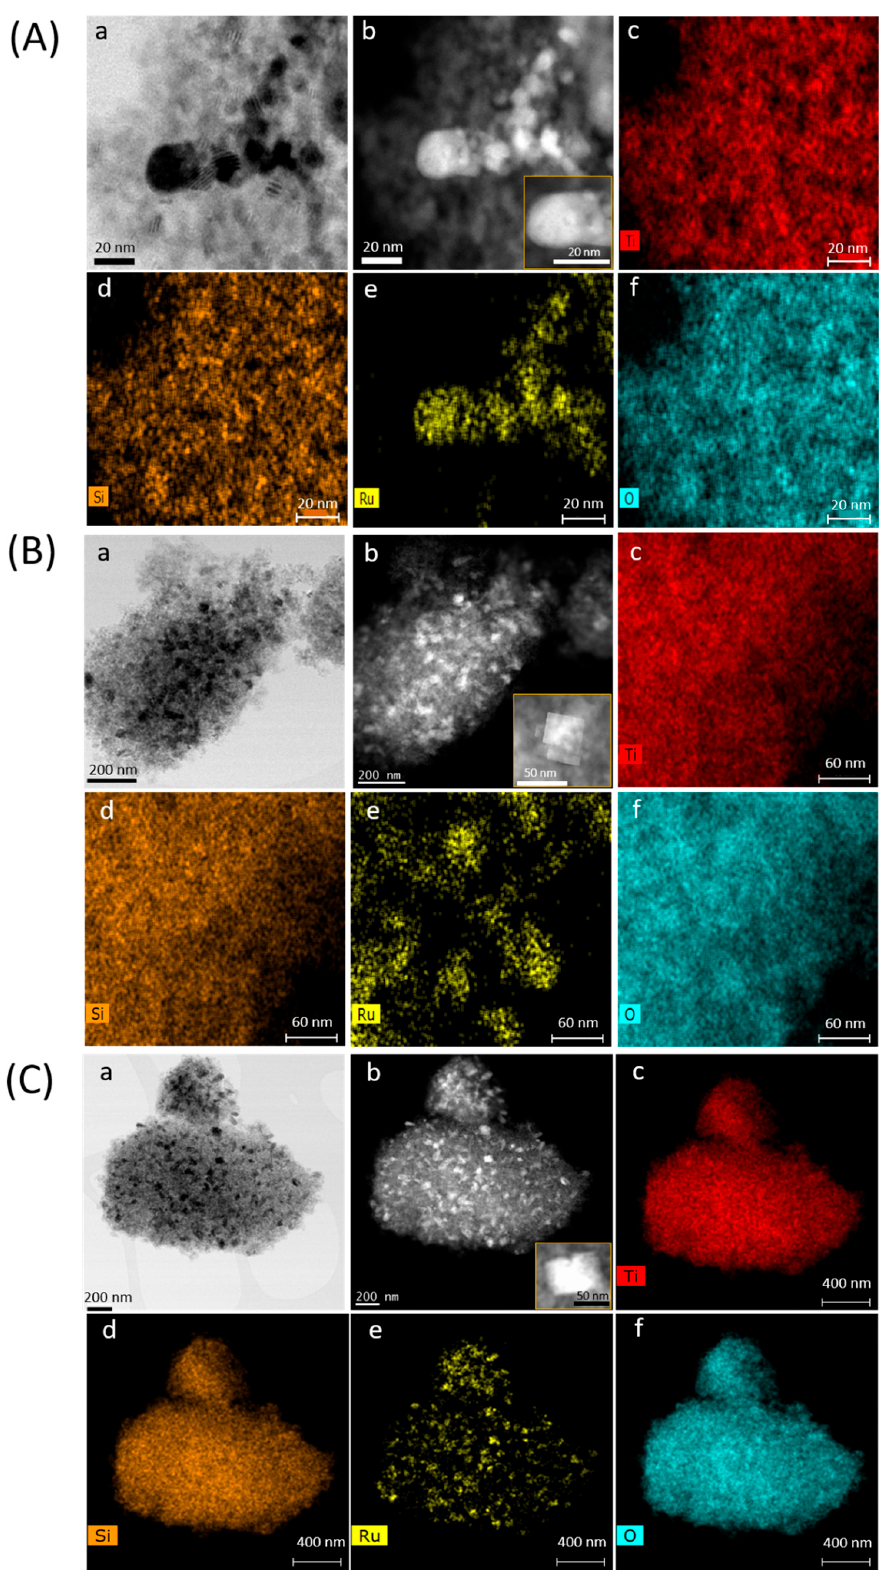
Figure 6. HAABF- (a) and HAADF-STEM (b) images together with corresponding energy dispersive X-ray (EDX) elemental mapping of Ti (c), Si (d), Ru (e), and O (f) for RuO 2 @TiO 2 -SiO 2 3:1-ns ( A ), RuO 2 @TiO 2 -SiO 2 3:2-ns ( B ), and RuO 2 @TiO 2 -SiO 2 3:3-ns ( C ) catalysts. Insets in subfigures b show a higher magnification of RuO 2 particles.